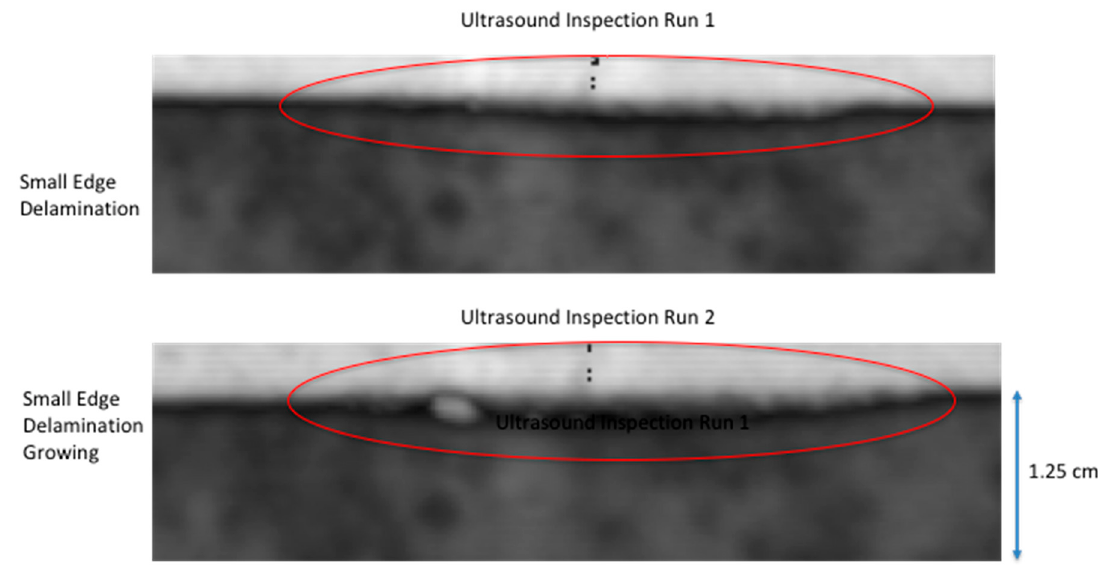
Figure 7. Ultrasonic inspection image after quasi-static load run 2 with comparison to run 1 ultrasonic inspection.